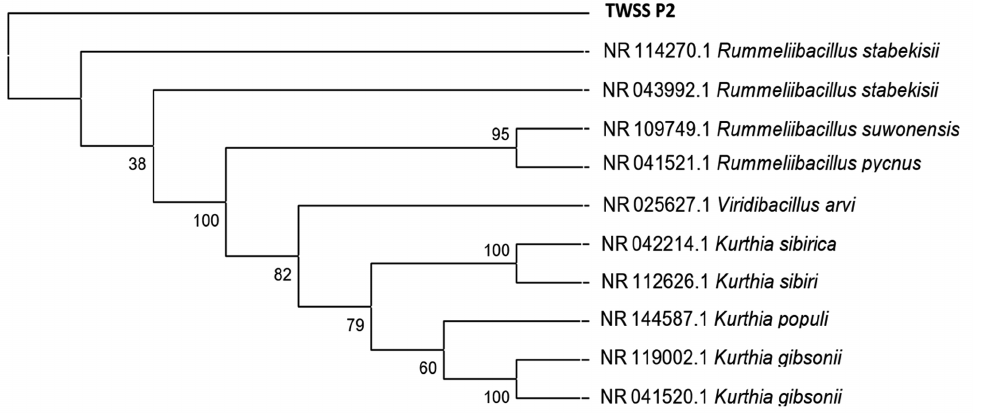
Fig. 7. Phylogenetic tree reconstructed applying maximum likelihood method and 1000 bootstrap replications.